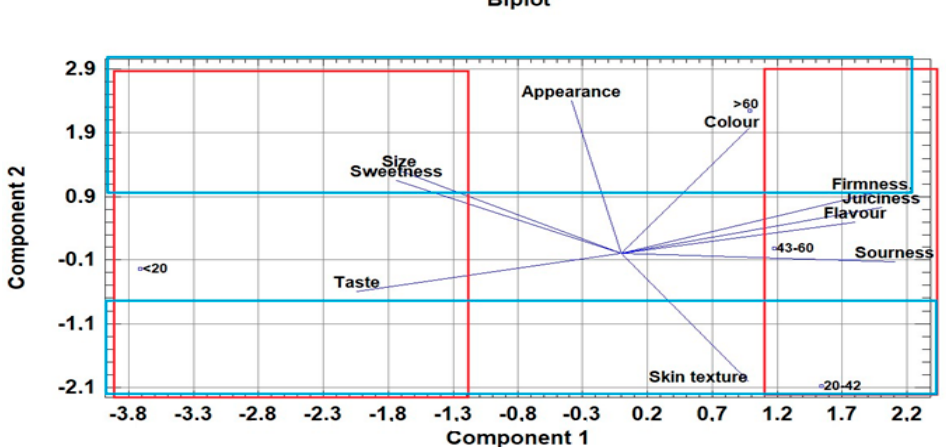
Figure 3. Principal component biplot of apple sensory attributes by different age group.